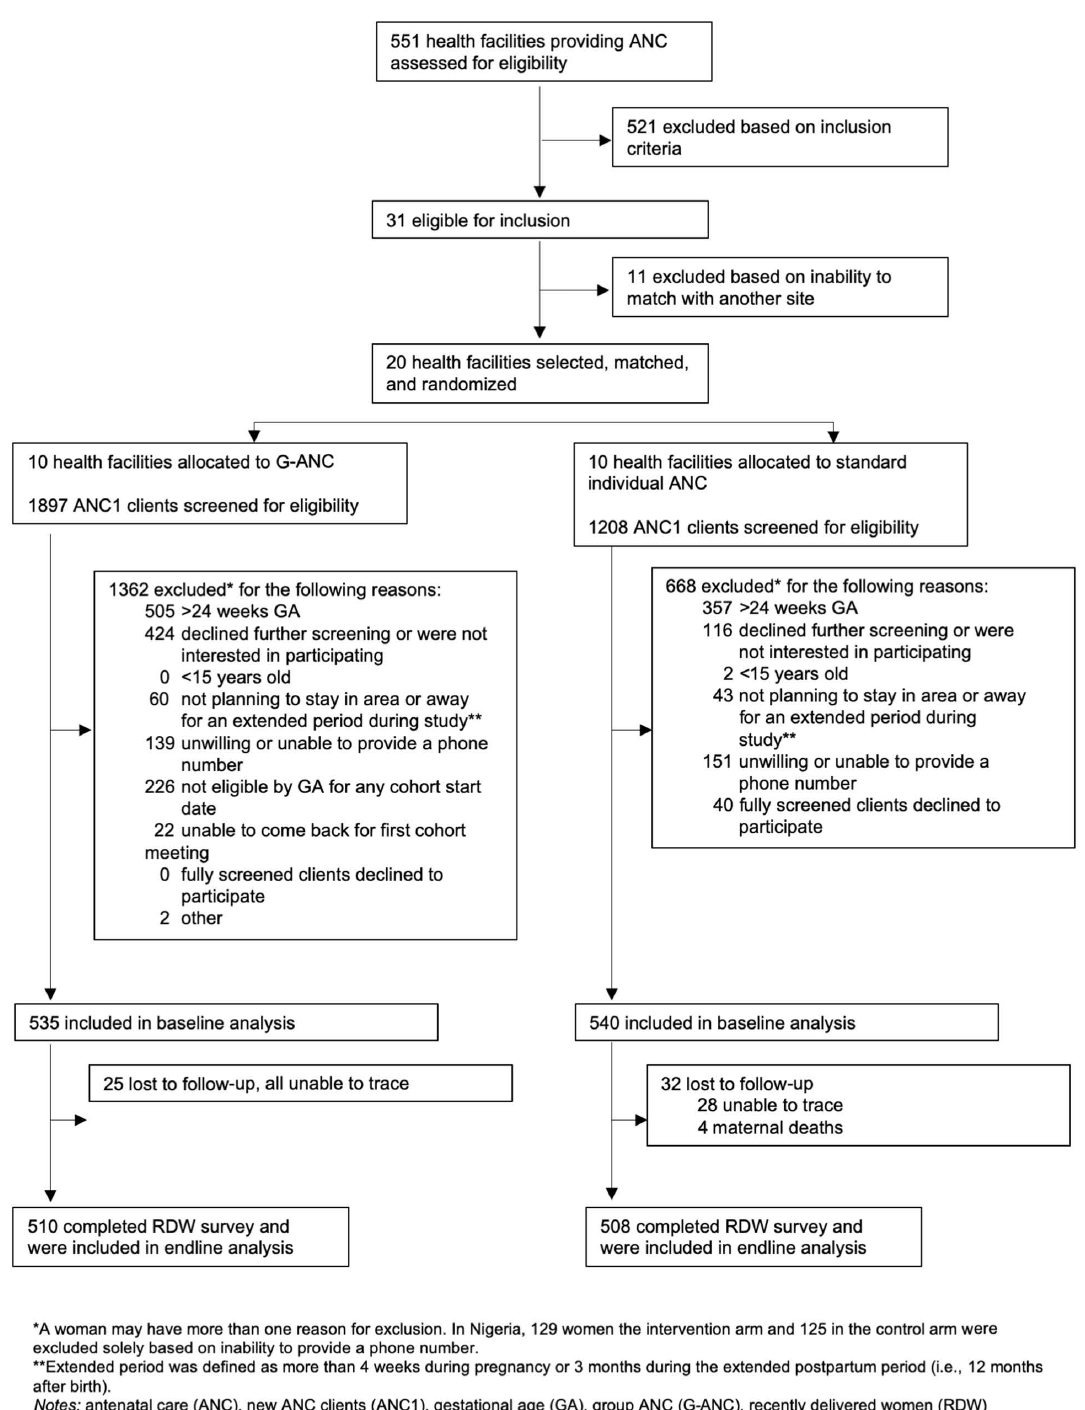
Figure 3. Enrollment of study participants in Nigeria. CONSORT flowchart of the eligibility screening, consent, and enrolment of study participants in